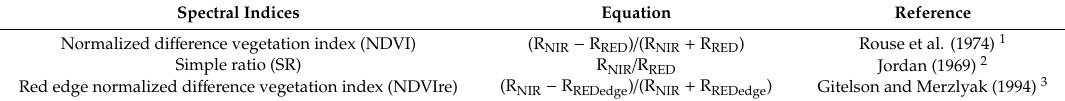
Table 3. Summary of spectral indices and their respective equations and references.